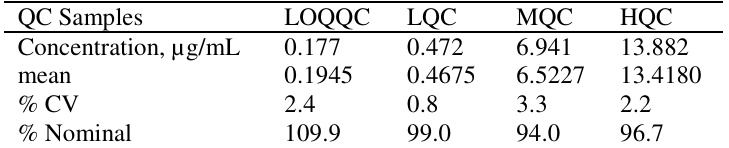
Table 2 . Precision & accuracy of fenofibric acid in human